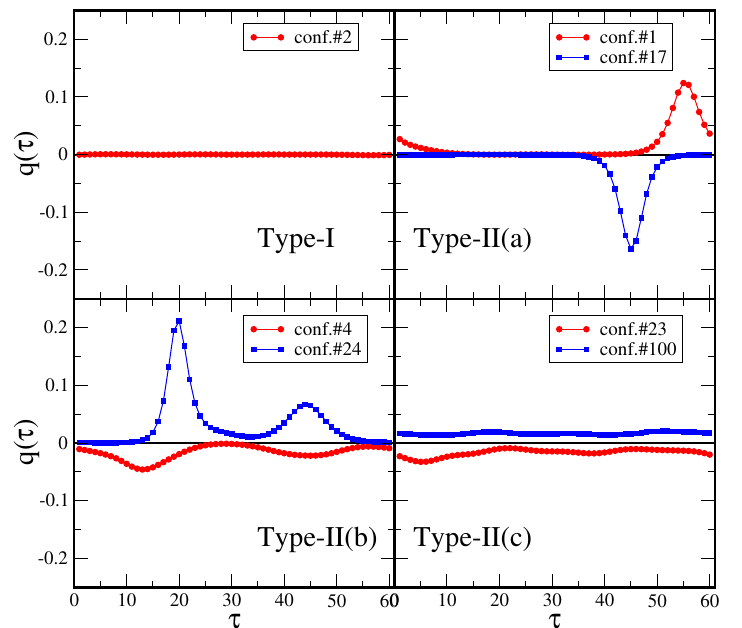
Figure 4 . Typical distributions of the local topological charges ( q ( (cid:28) )). The integer-instanton and integer-anti-instanton are shown in the top-right panel. On the other hand, the topological charges are \fractionalized" in the bottom-left panel (see eq.